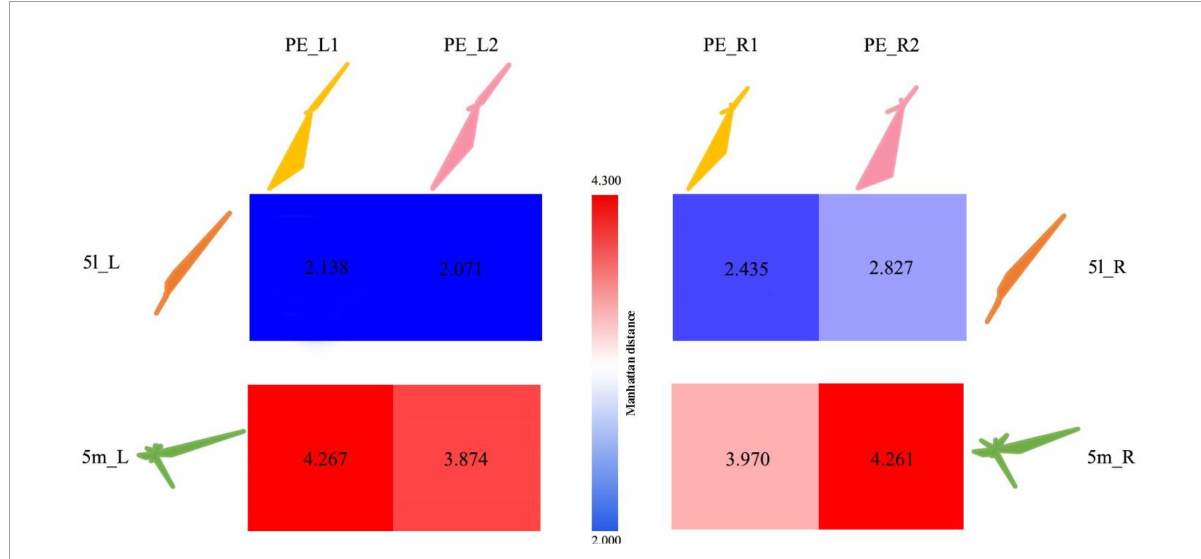
FIGURE7 Comparison of anatomical connections between 5L and 5m in humans and subregions of the PE. 5l_L represents the 5L area in the left hemisphere of the human brain; 5l_R represents the 5L area in the right hemisphere of the human brain; 5m_L represents the 5m area in the left hemisphere of the human brain; 5m_R represents the 5m area in the right hemisphere of the human brain area. PE_L1 represents the PE_1 region in the left hemisphere of the macaque brain; PE_L2 represents the PE_2 region in the left hemisphere of the macaque brain; PE_R1 represents the PE_1 region in the right hemisphere of the macaque brain; PE_R2 represents the PE_2 region in the right hemisphere of the macaque brain. The numbers in the squares represent the Manhattan distance between the corresponding areas of the monkey brain and the human brain, with red representing far distance and blue representing near distance.